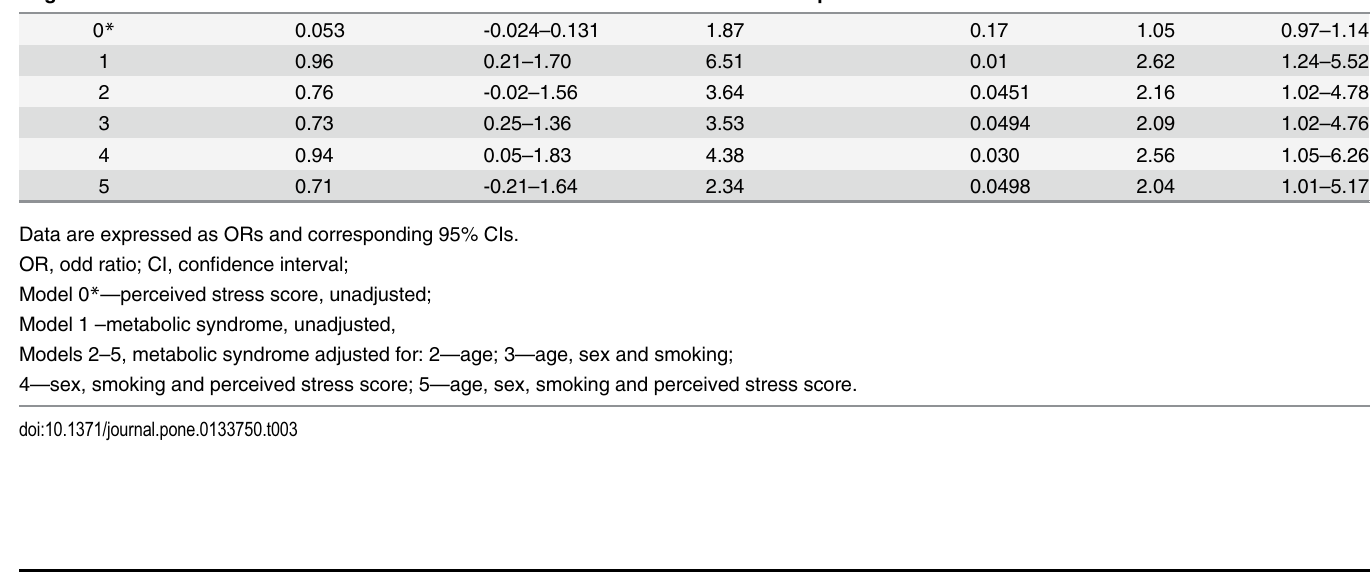
Table 3. Models of logistic regression analysis: assessment of the impact of metabolic syndrome on the coronary plaque prevalence, depending on the correcting variable. Regression